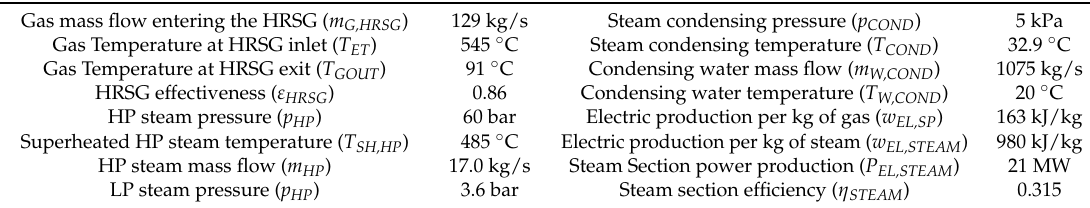
Table 1. GSCC steam section main data (design conditions).